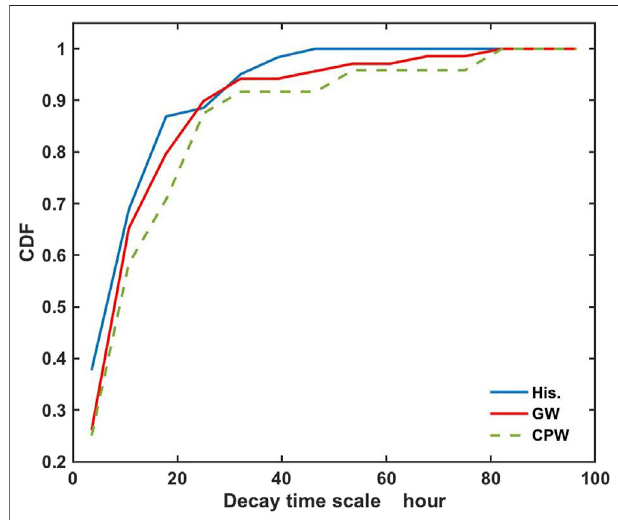
FIGURE 10 | Compared CDFs of TC decay time scale between the present-day (1979 – 2003, solid blue line), global warming ensemble mean (2075 – 2099, solid red line), and the CP warming cluster (dashed green line) according to RCP8.5 scenario, respectively, based on the MRI-AGCMs